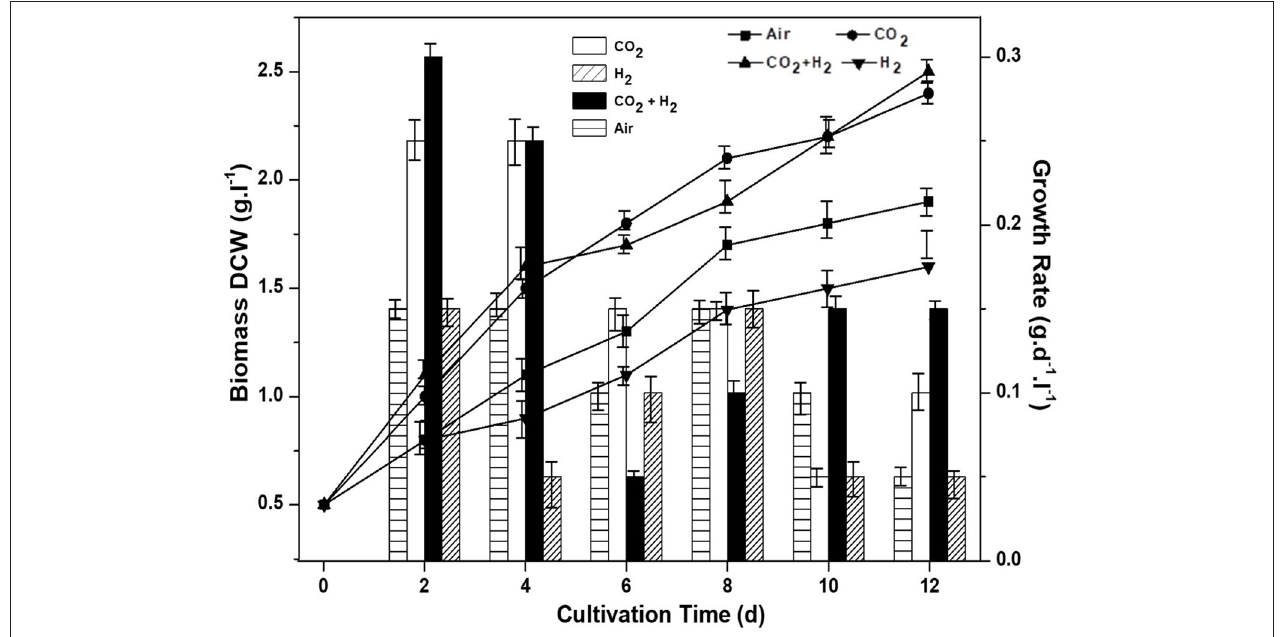
FIGURE 1 | Influence of specific gas inlet in the headspace on biomass concentration (g.L − 1 ) and biomass productivity (g.L − 1 .d − 1 ) of the microalgal